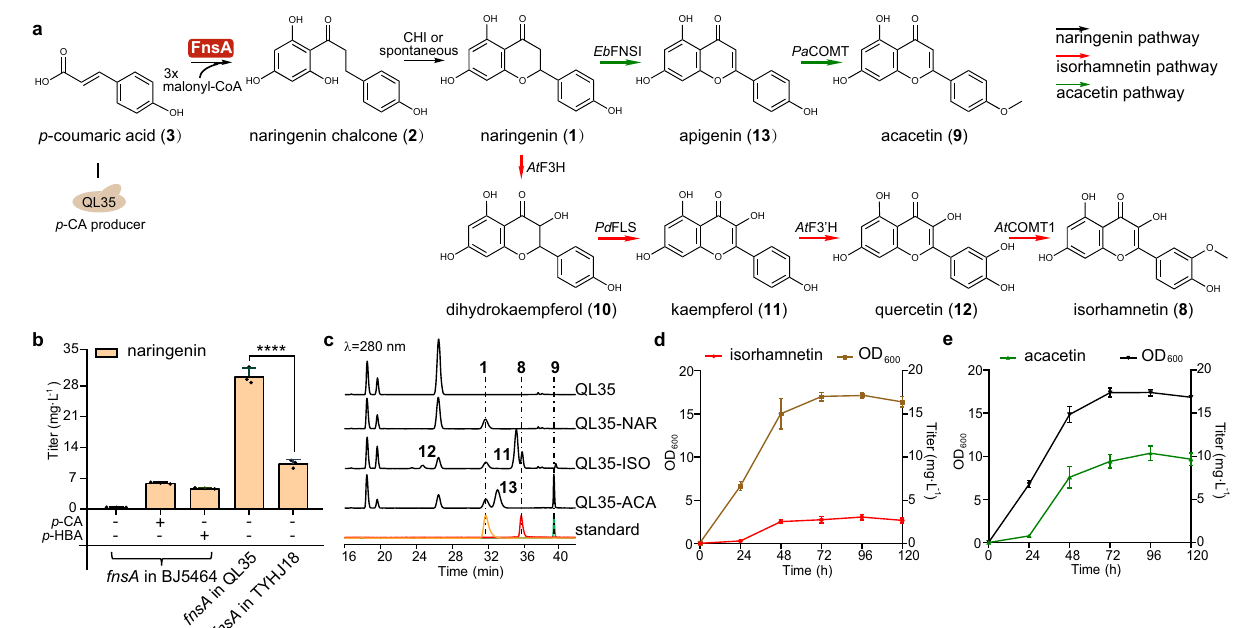
Fig. 6 | De novo biosynthesis of plant fl avonoids in S. cerevisiae . a Schematic illustration of the engineered biosynthetic pathways leading to the production of plant fl avonoids isorhamnetin ( 8 )and acacetin( 9 ). Eb FNSI, fl avone synthase I from E. breviscapus ; Pa COMT, fl avone 4 ’ -O-methyltransferase from P. appendiculatum ; At F3H, fl avanone 3-hydroxylase from A. thaliana ; Pd FLS, fl avonol synthase from P. deltoides ; At F3 ’ H, fl avonol 3 ’ -hydroxylase from A. thaliana ; At COMT1, O-methyltransferase 1 from A. thaliana . b Yield assessment of naringenin ( 1 ) sup- plying with or without the substrate p -CA or p -HBA in different engineered yeast strains. BJ5464, S. cerevisiae BJ5464-NpgA; QL35, p -CA high production strain;